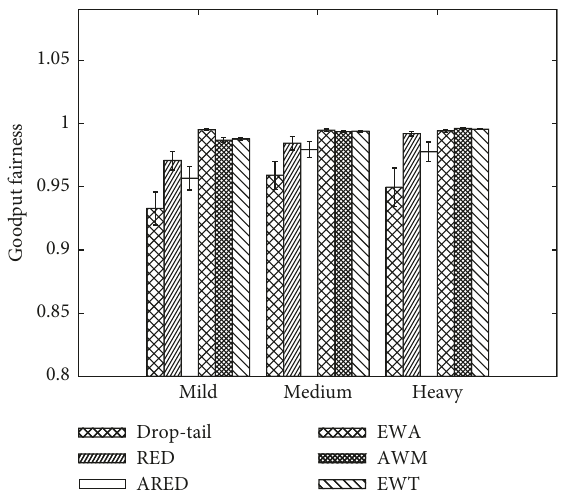
Figure 16: Number of flows needed to meet RFC 7928 in Scenario 1.